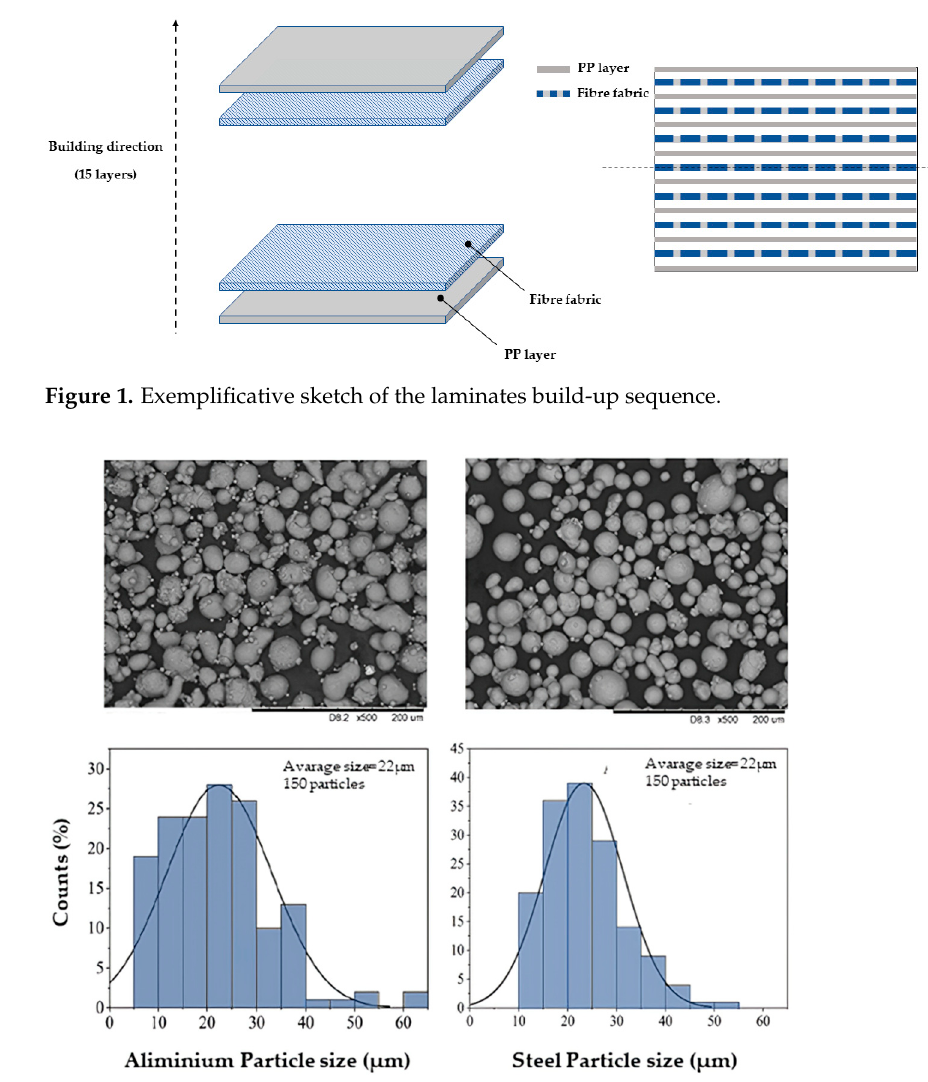
Figure 2. SEM micrographs and granulometry of the aluminum powders ( left ) and AISI316L powders ( right ).